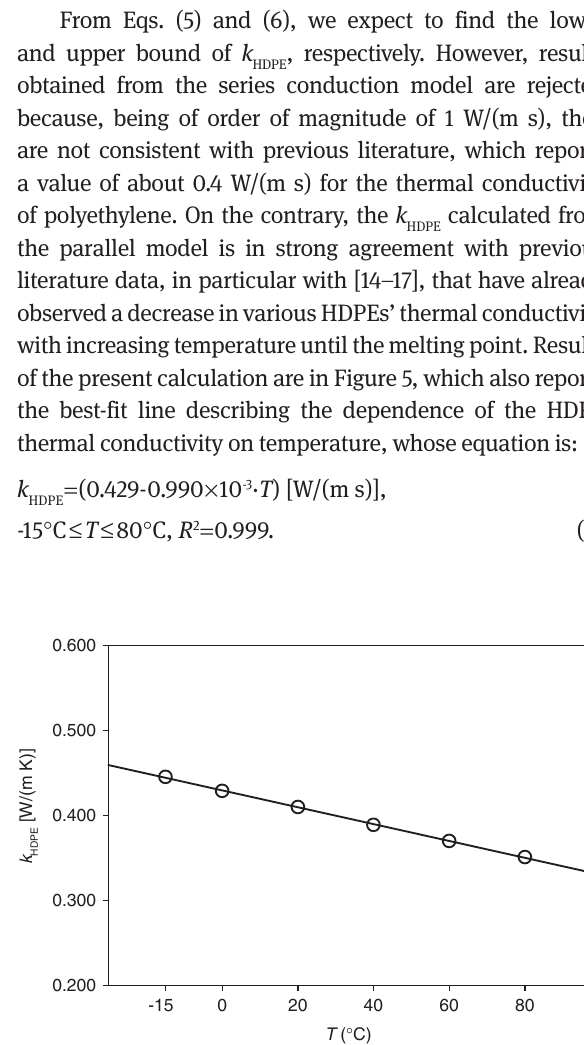
Figure 4 Dependence of the thermal conductivity of the PE panel on temperature (mean values with 95% confidence intervals are reported).